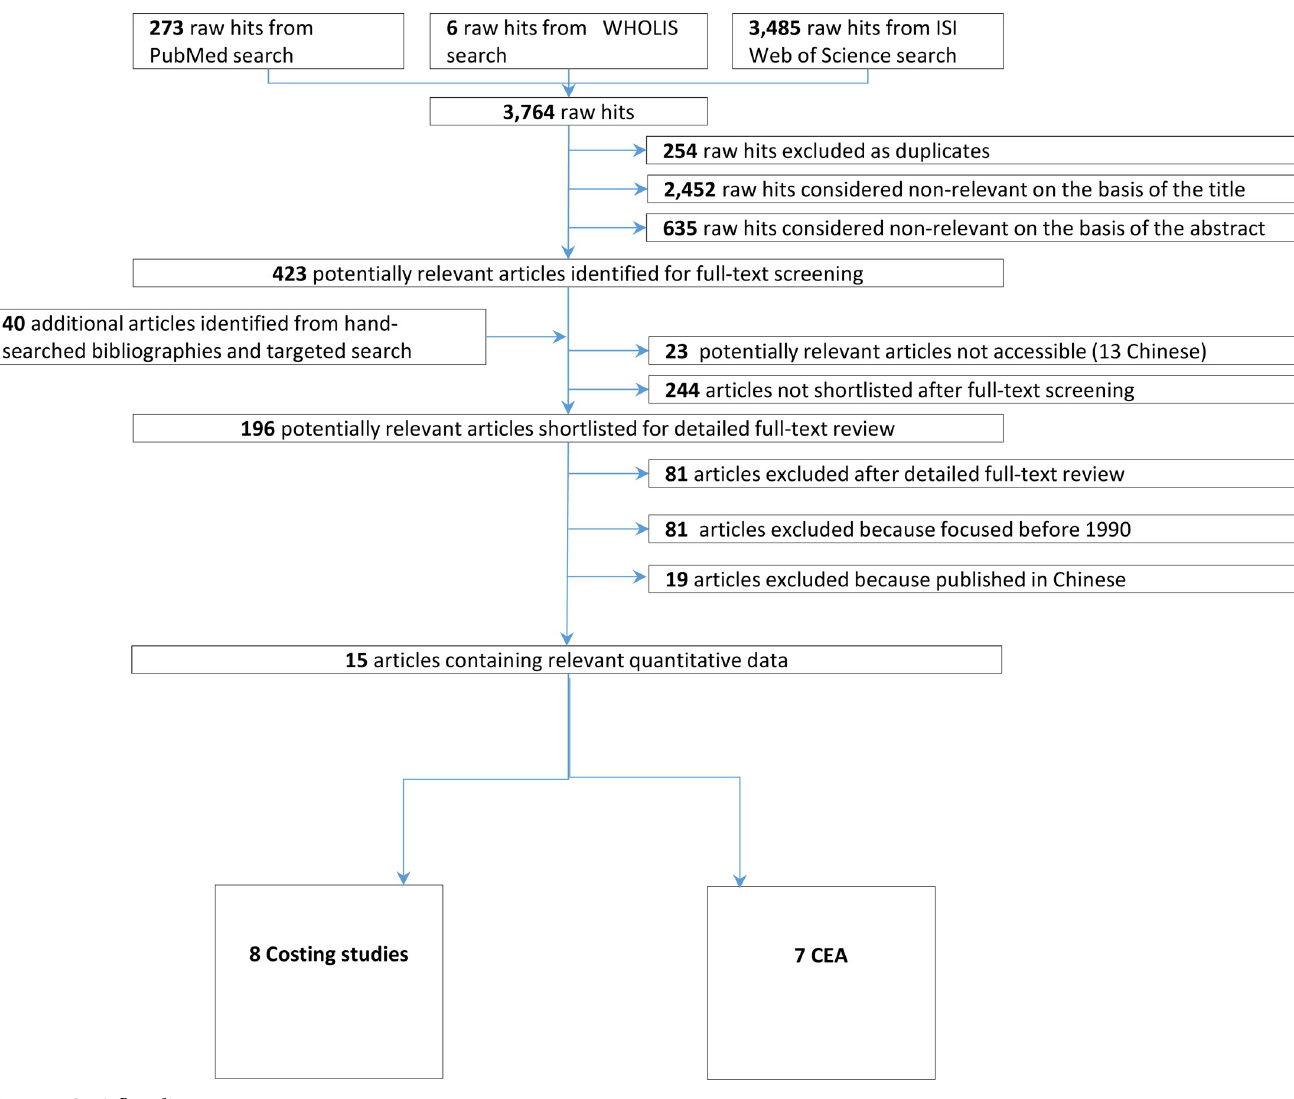
Fig 1. PRISMA flow